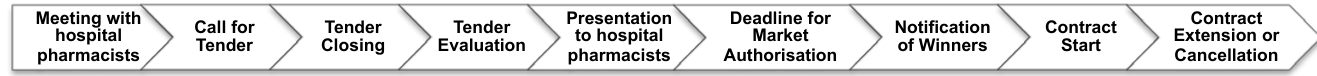
Figure 1: The procurement